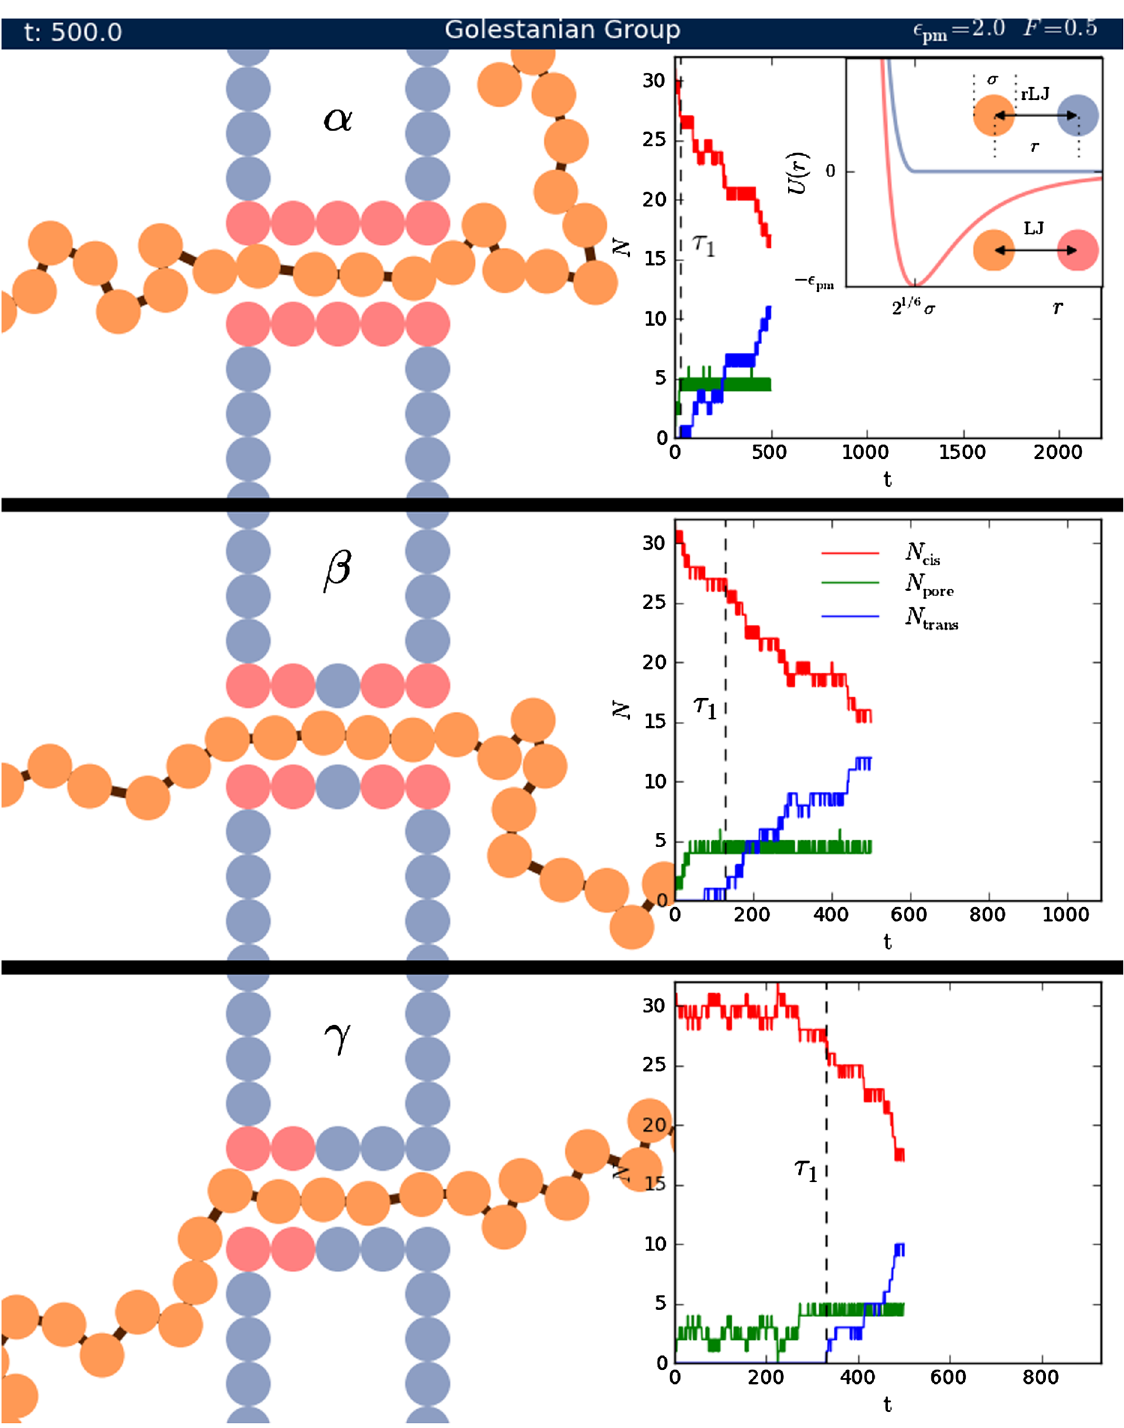
VIDEO 1. Homopolymer translocating through Pores (cid:2) , (cid:3) , and (cid:4) . A homopolymer of length N ¼ 32 is shown translocating through the three pore patterns considered in this study. The upper panel shows Pore (cid:2) , which is attractive throughout, the middle panel shows Pore (cid:3) , which has a short-range repulsive core, and the lower panel shows Pore (cid:4) , which has an attractive entrance. On the right, the number of monomers is counted in the cis (red), pore (green), and trans (blue) regions as a function of time for each pore. The filling, (cid:6) 1 , transfer, (cid:6) 2 , and escape time, (cid:6) 3 , are marked when the event occurs. The runs selected have a translocation time near that of the mean translocation time. The parameters, as explained in the paper, are W ¼ 2 : 25 , (cid:1) pm ¼ 2 : 0 , and F ¼ 0 : 5